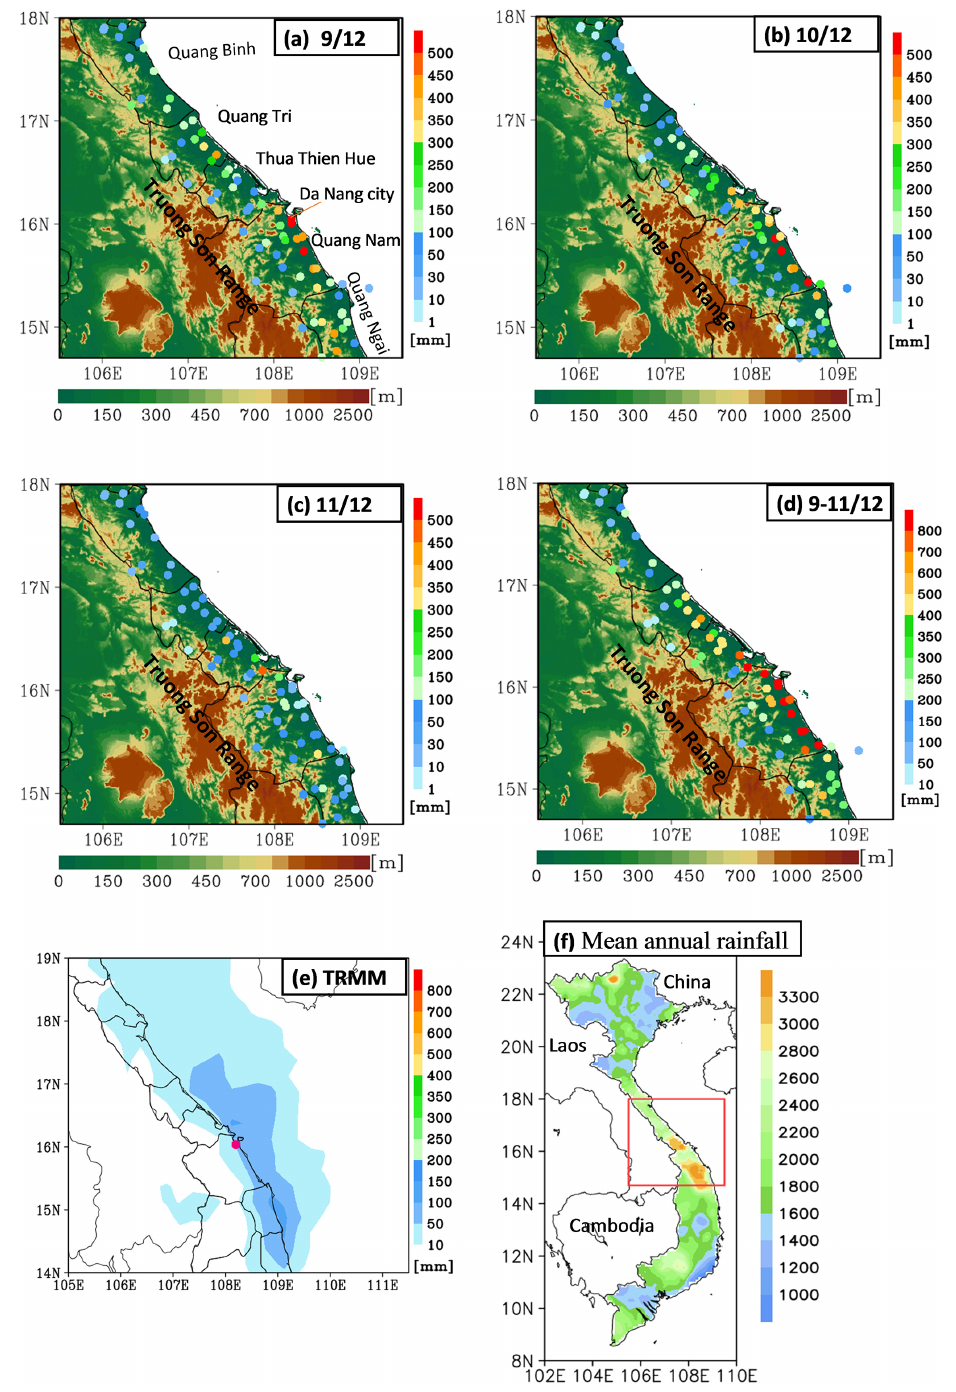
Figure 1. (a) Observed 24h accumulated rainfall (mm, color dots, 12:00–12:00UTC) and topography (m, shaded) for 9 December. Vertical color bar for rainfall and horizontal color bar for topography. (b) As in panel (a) , but for 10 December. (c) As in panel (a) , but for 11 De- cember. (d) As in panel (a) , but for 72h accumulated rainfall during 12:00UTC on 8 December to 12:00UTC on 11 December. (e) 72h accumulated rainfall obtained by the Tropical Rainfall Measuring Mission (TRMM) estimate. The pink dot marks the location of Da Nang station. (f) Mean annual rainfall distribution (mm) in Vietnam from 1980 to 2010, obtained from the Vietnam Gridded Precipitation (VnGP) data, and the study area of central Vietnam (red